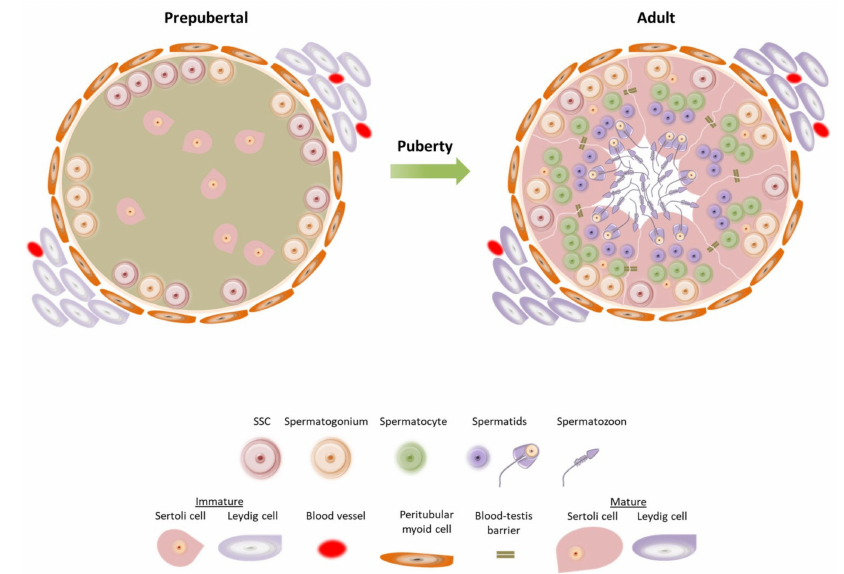
Figure 1. Schematic representation of a seminiferous tubule cross-section from a prepubertal and